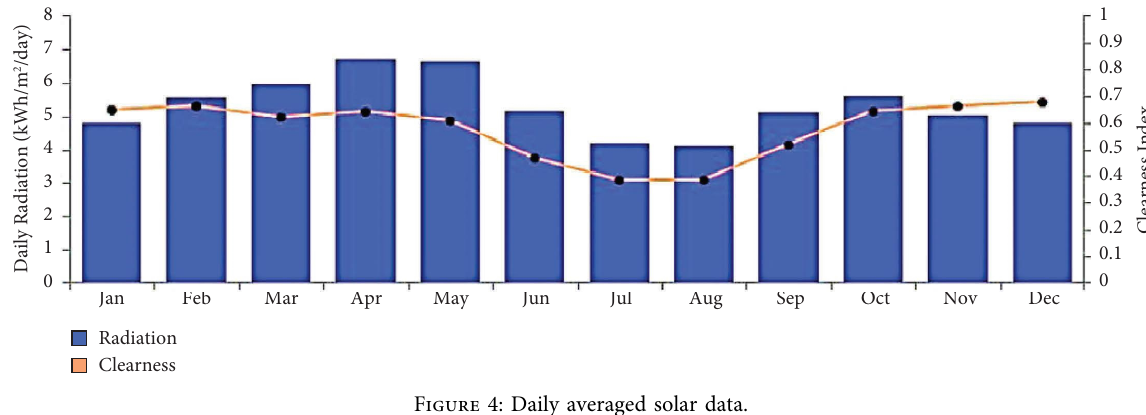
Figure 4: Daily averaged solar